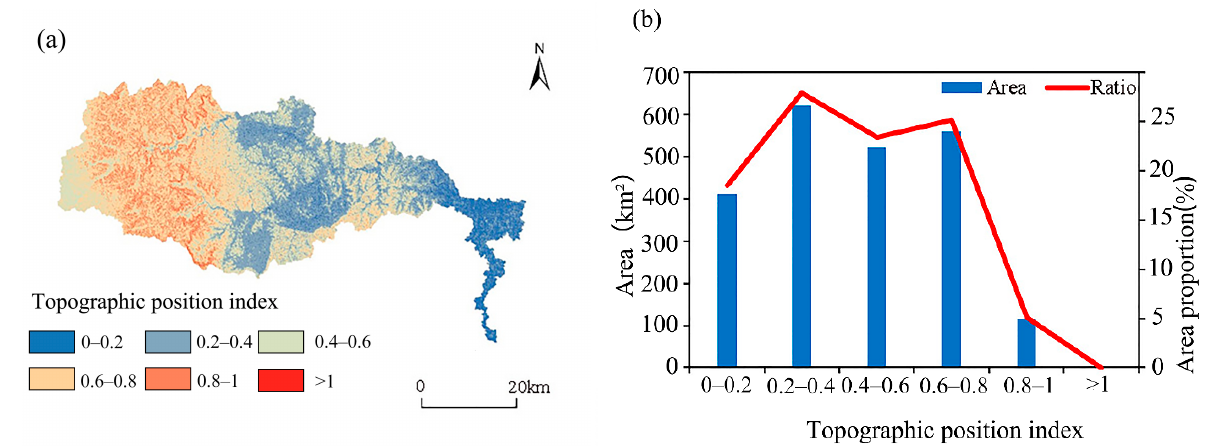
Figure 6. Changes in total ESV ( a ) and individual ESVs ( b ) in the Qihe watershed by topographic position index from 2000 to 2015. A significant increase in watershed ESV (CNY 25.22 million) and an increase in woodland ESV of CNY 6.85 million occurred within TPIs of 0.2–0.4. The high ESV coeffi- cient of water areas was the major factor behind the significant increase in water ESV, while arable land and grassland ESV decreased by CNY 12.5 million CNY and CNY 3.2 million CNY. Small overall changes in the ESV of areas with TPI from 0.4 to 0.6 were due to increases in water, grassland, and woodland ESVs and decreases in arable land ESV.